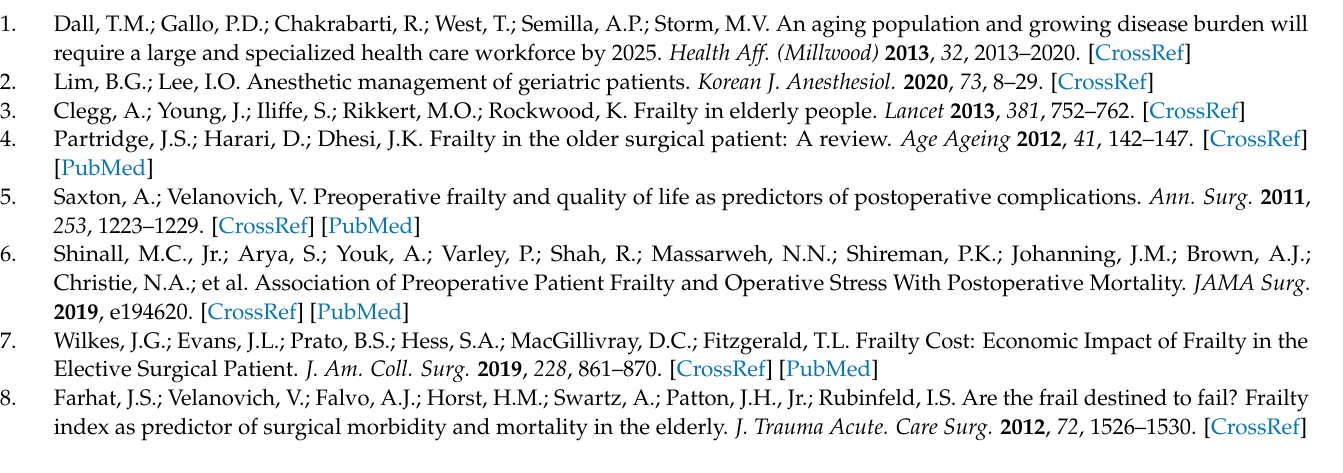
Figure S2: Distribution of operation frailty risk score by surgical departments, Table S1: Operation group classified by clinical experts, Table S2: Univariate and multivariable regression analysis model for 90-day mortality in the development